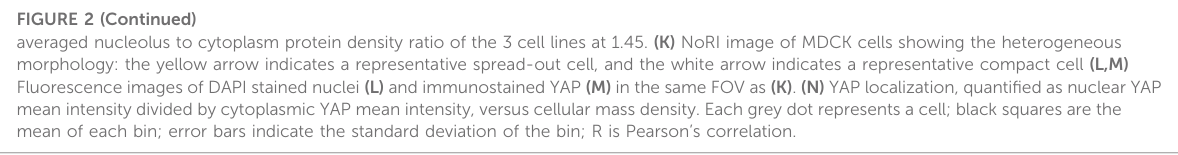
FIGURE 2 (Continued) averaged nucleolus to cytoplasm protein density ratio of the 3 cell lines at 1.45. (K) NoRI image of MDCK cells showing the heterogeneous morphology: the yellow arrow indicates a representative spread-out cell, and the white arrow indicates a representative compact cell (L,M) Fluorescence images of DAPI stained nuclei (L) and immunostained YAP (M) in the same FOV as (K) . (N) YAP localization, quanti fi ed as nuclear YAP mean intensity divided by cytoplasmic YAP mean intensity, versus cellular mass density. Each grey dot represents a cell; black squares are the mean of each bin; error bars indicate the standard deviation of the bin; R is Pearson ’ s